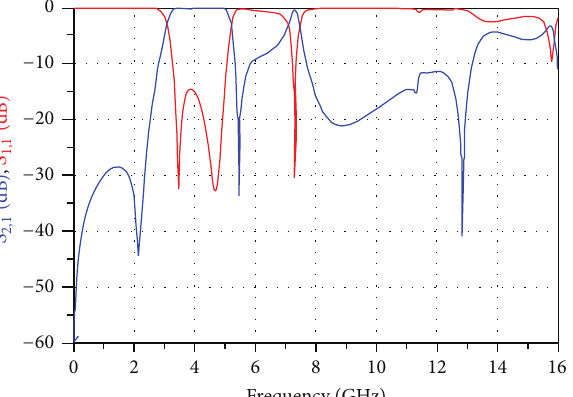
Figure 18: Frequency response of the simulated filter in the workspace of ADS plotted versus return losses (𝑆 11 ) and insertion losses (𝑆 21 ) in the range of 0–16